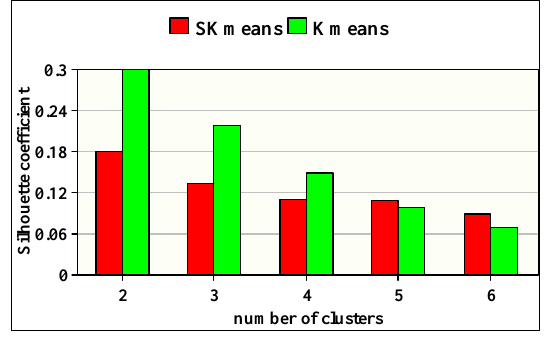
Figure 9. Clustering accuracy of SKmeans and Kmeans.